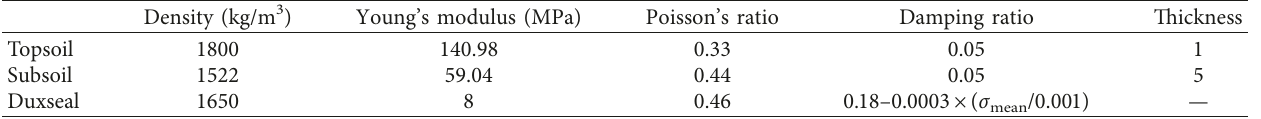
Table 1: Calculation parameters of soil and Duxseal.